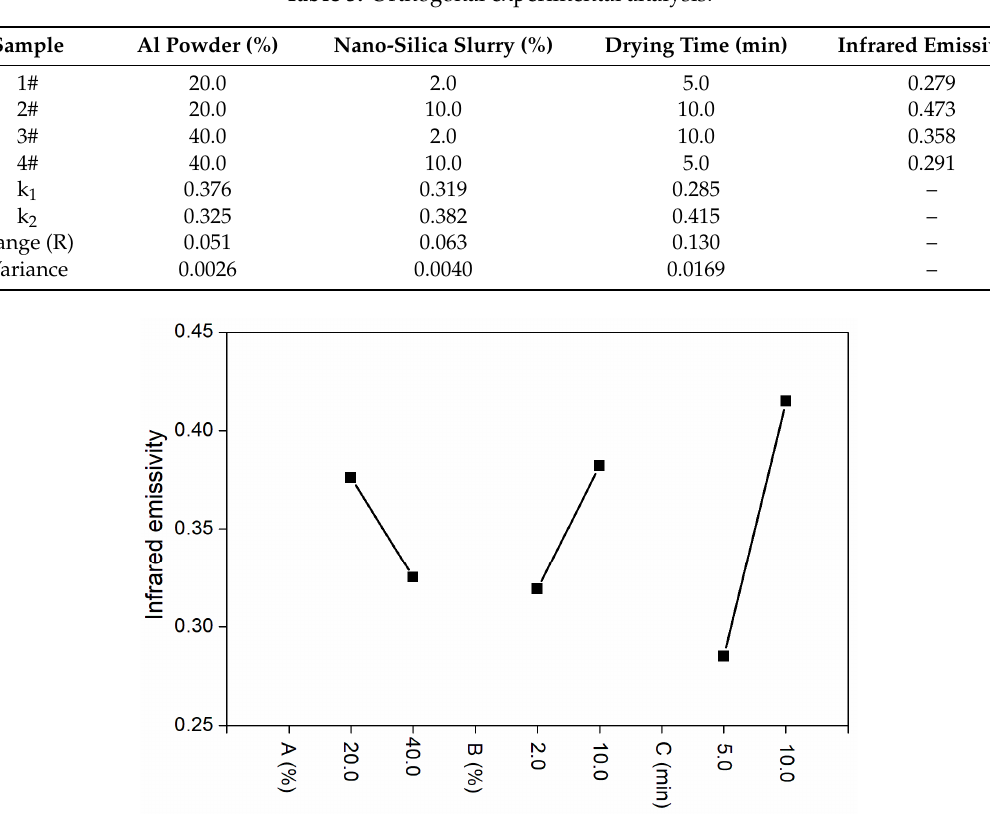
Figure 1. Orthogonal experimental effects of (A) Al powder, (B) nano-silica slurry concentration, and (C) drying time.